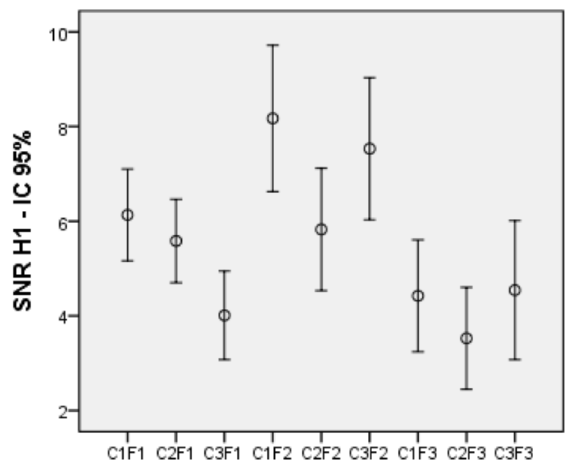
Figure 5. SNR means for the 9 conditions of the 1st harmonic with 95% confidence intervals.